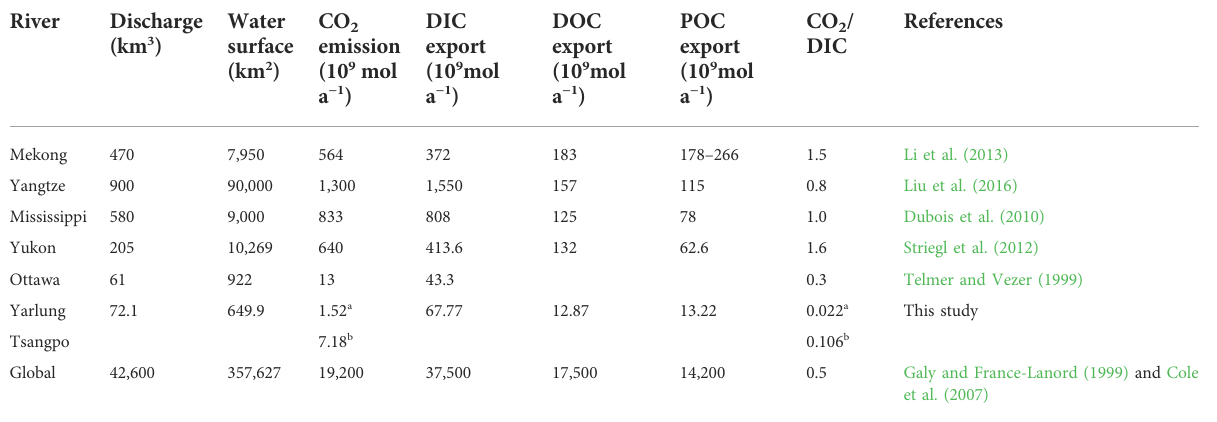
TABLE 3 CO 2 evasion fl uxes and carbon transport by several large